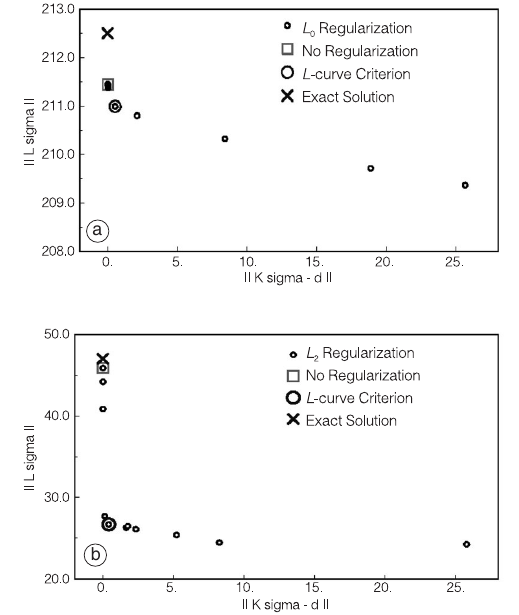
Fig. 6a,b. L-curve obtained from data d in fig. 4b with regularization imposed by: a) L arithmetic).